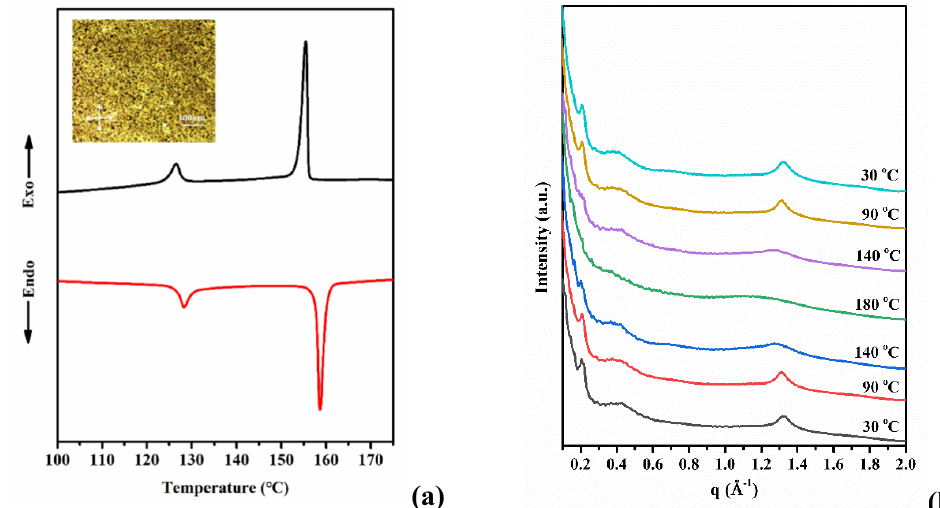
Figure 2. ( a ) The DSC curve of the polymer CNT-PDB. Inset image: POM image of the polymer CNT-PDB at 140 °C. ( b ) X-ray scattering profiles of the polymer CNT-PDB recorded at various temperatures upon heating and cooling.